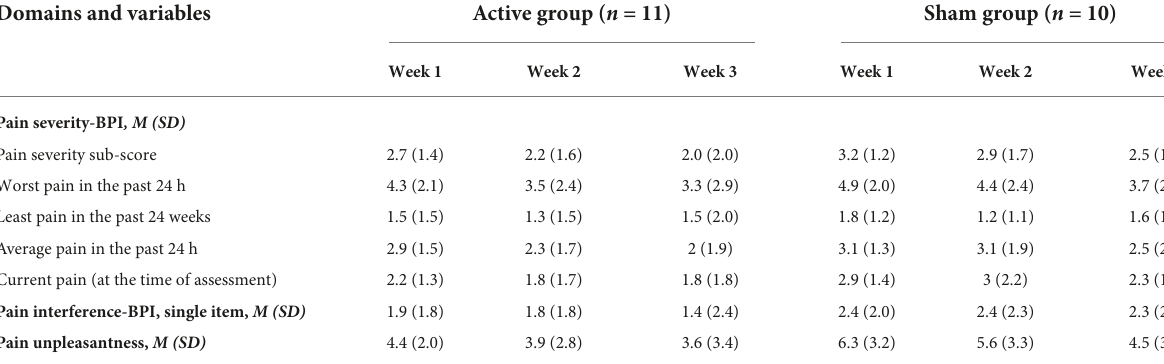
TABLE 5 Pain and interference measures during NF training